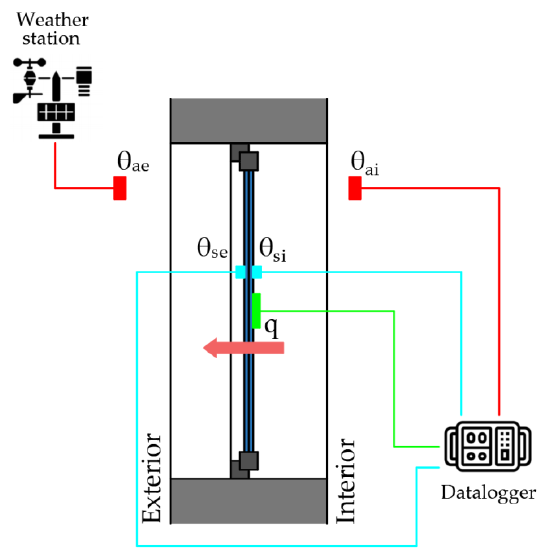
Figure 4. The principle of experimental measurement in the pavilion laboratory.